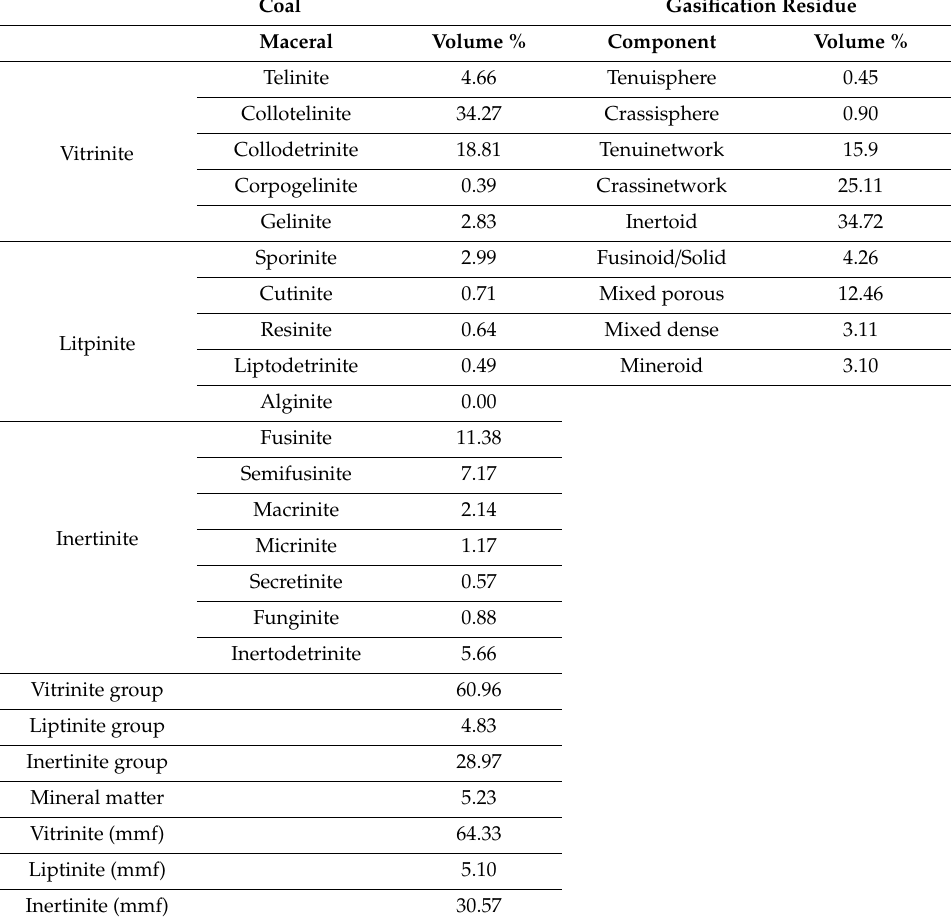
Table 3. Petrographic composition of coal from the Janina deposit and the gasification residue